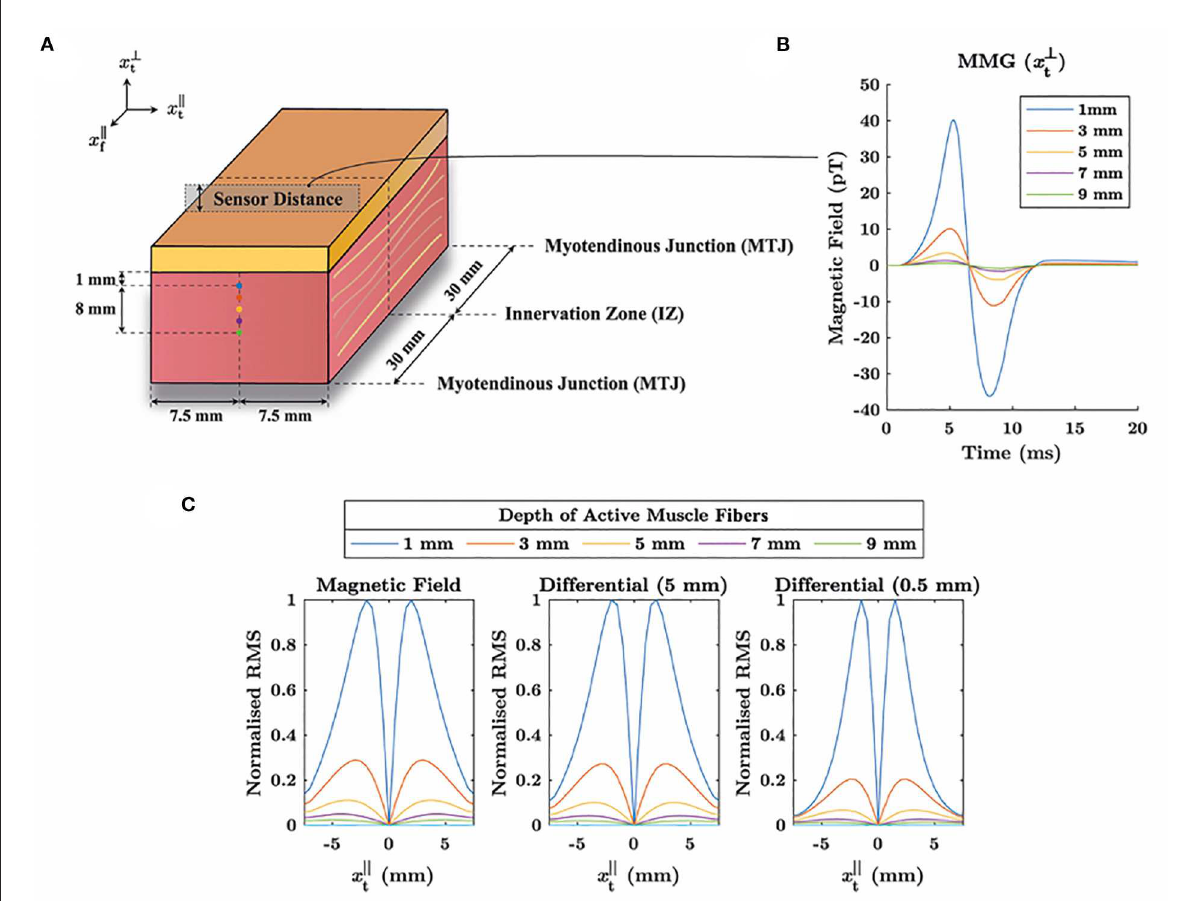
FIGURE7 (A) For a cube-shaped muscle compound, muscle action potentials are simulated when muscle fibers in different depths are stimulated. A 2 mm thick fat tissue layer is added on top of the muscle, and the magnetic field is observed midway between the innervation zone (IZ) and the myotendinous junction (MTJ). For obtaining a differential signal, the magnetic field is sampled at the body surface and in a line with distance 1 x ⊥ t above the muscle surface. (B) Exemplary MMG signal measured at one point with a distance of 0.5 mm to the body surface when varying the depth of the active muscle fibers. (C) Signal amplitude on the body surface in a line perpendicular to the muscle fibers (cf. A ). The left column shows the root mean square (RMS) of the raw MMG signal, depending on the spatial coordinate and the depth of the active muscle fibers. The middle and the right column show the RMS distribution corresponding to differential signals with inter-sensor distances of 5 and 0.5 mm, respectively. Thereby, it can be observed that decreasing the distance between the sensors narrows the amplitude distributions and hence reduces the detection volume of